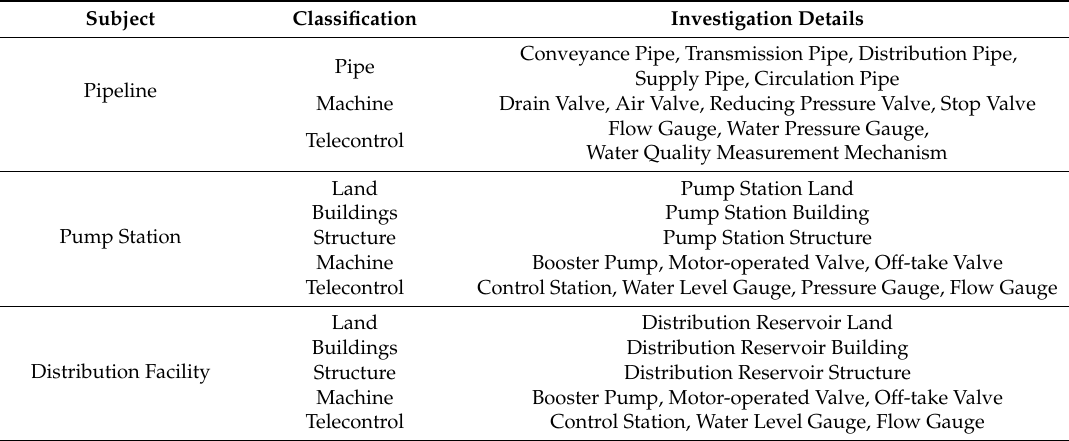
Table 2. Subjects of water supply